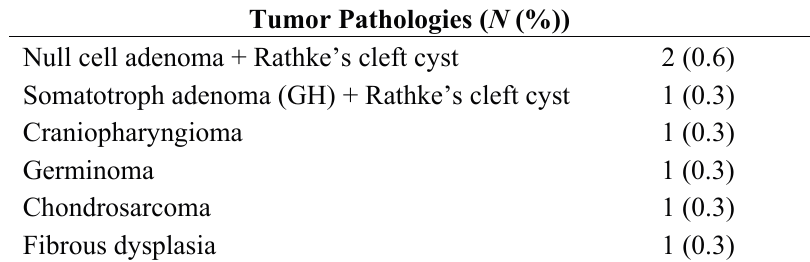
Tumor Pathologies ( N